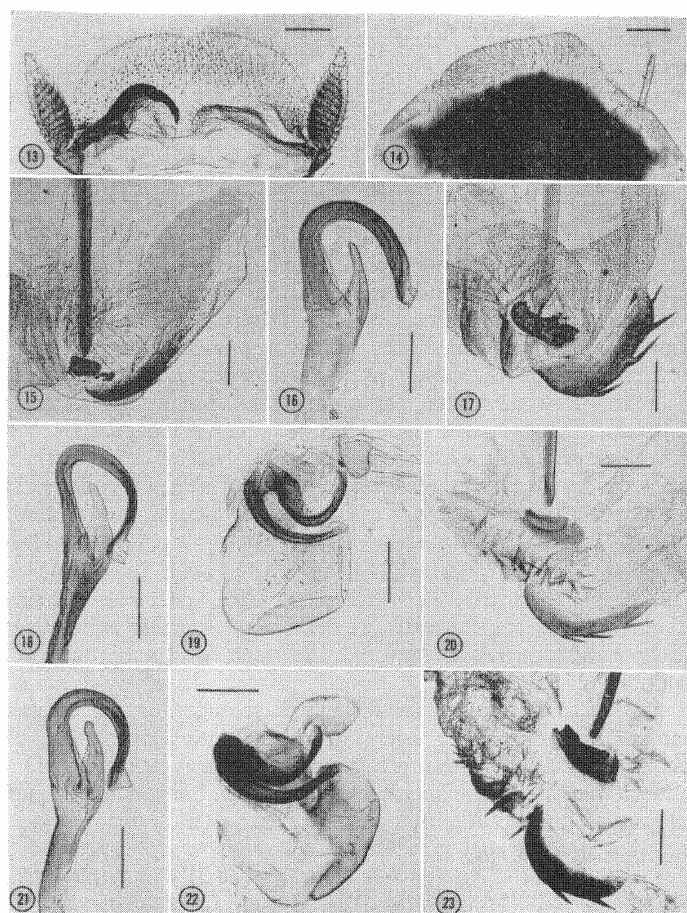
Figs. 13-23. Pinaconota bifasciata. Male structures. 13-14. Supra-anal plate (dorsal) and subgenital plate (ventral; left style missing), re- spectively. From male taken at Miami (with orchids from Brazil), 26 July, 1971. 15-23. Genital phallomeres: 15-16. L2vm, L2d, and prepuce (15) and R2 (16), from shown in fig. 5. 17-19. L2d and prepuce (17), R2 (18), and L1 (19) from shown in fig. 1. 20-21. L2d, and prepuce (20), and R2 (21), from shown in fig. 7. 22-23. L1 (22), and L2d and prepuce (23), of male whose supra-anal and subgenital plates are shown in figs. 13 and 14. (scale: figs. 13-14 -"- 0.5 mm; all others 0.3 mm; all figures from KOH cleared, flattened